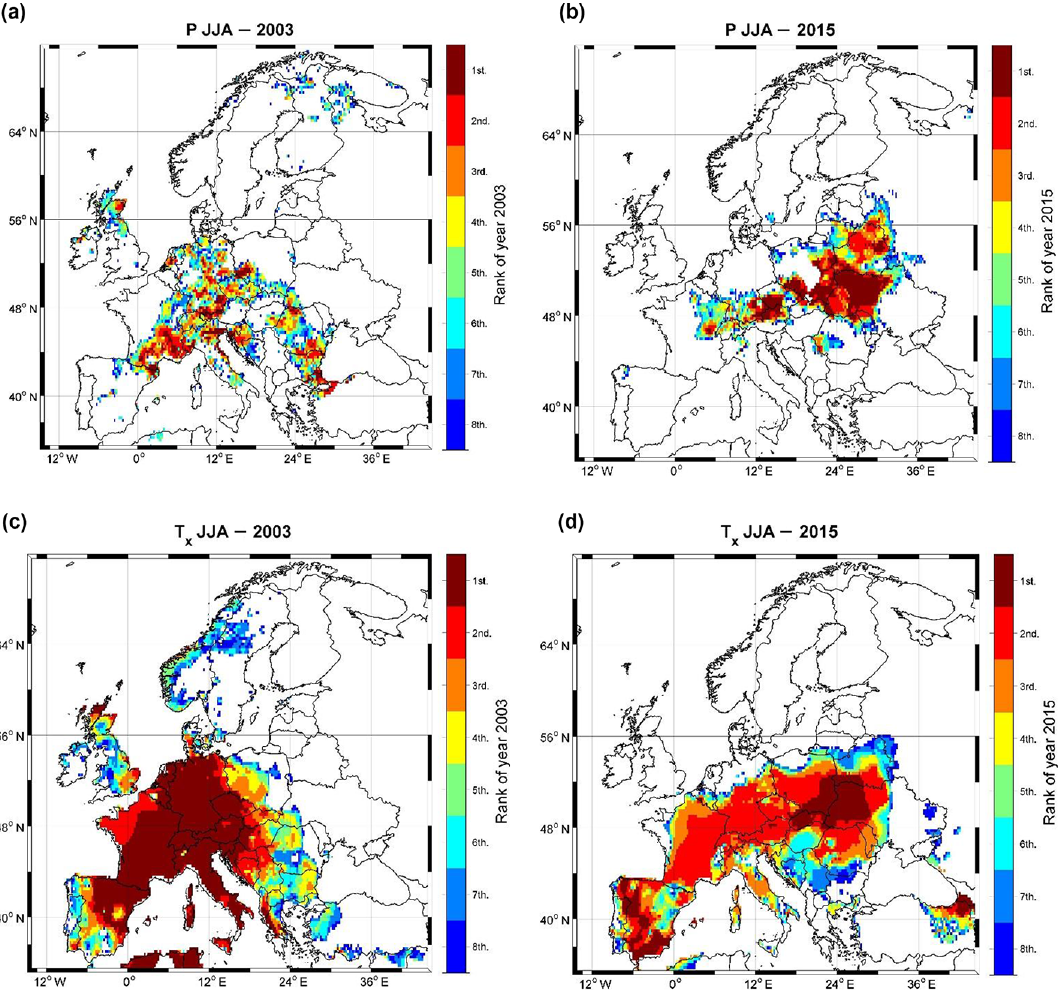
Figure 7. (a) Top-eight ranking of 2003 summer P ; (b) Top-eight ranking of 2015 summer P ; (c) Top-eight ranking of 2003 summer T x and (d) Top-eight ranking of 2015 summer T x . 1 means the driest (P) and warmest ( T x ) summer since 1950, 2 signifies the second driest, etc., and all ranks greater than 8 are shown in white. Analyzed period: